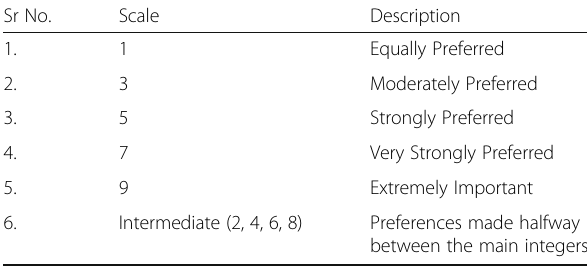
Table 1 Scale for Pairwise